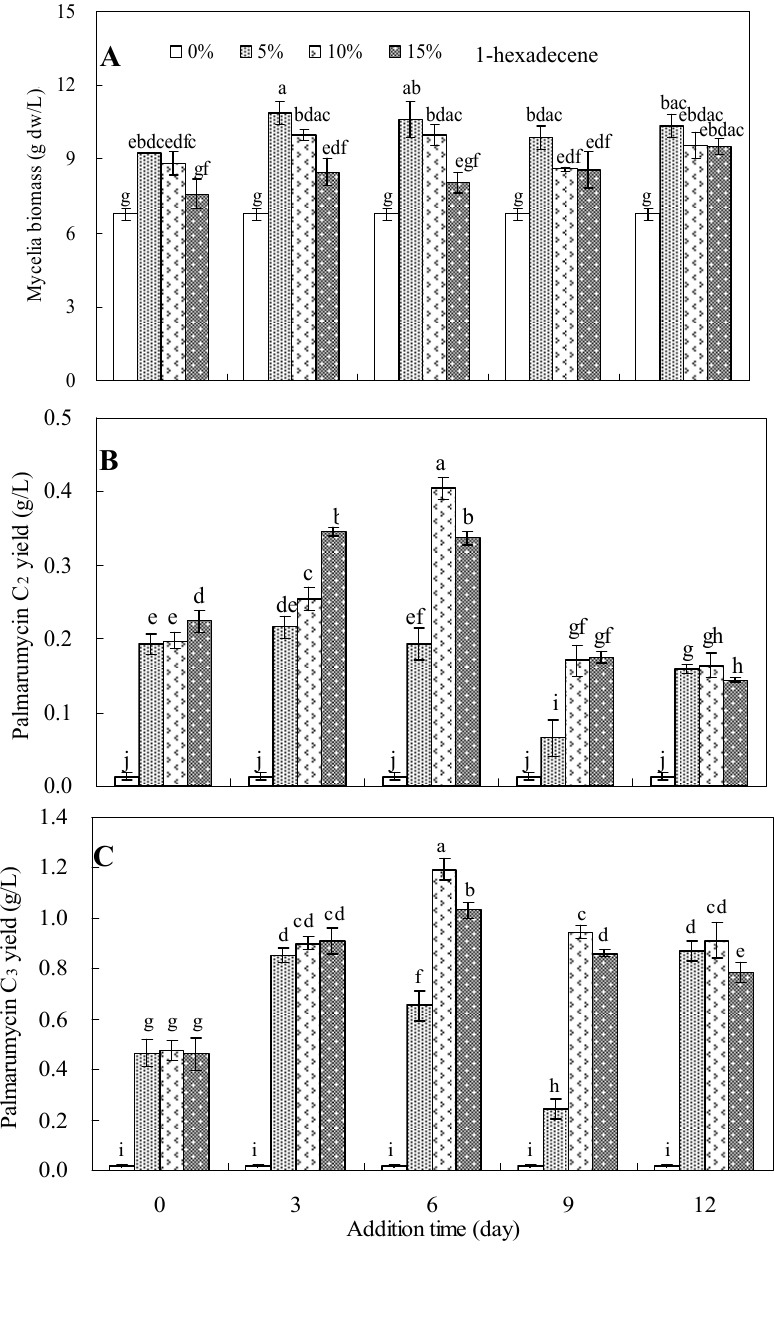
Figure 4. Effects of 1-hexadecene and its addition time on mycelia biomass ( A ), palmarumycin C ( B ) and palmarumycin C ( C ) production in liquid culture of 2 3 Berkleasmium sp. Dzf12. 1-Hexadecene was applied at 5%, 10% and 15% on days 0, 3, 6, 9, and 12 of culture, respectively. The error bars represent standard deviations from three independent samples. Different letters indicate significant differences among the treatments at p = 0.05